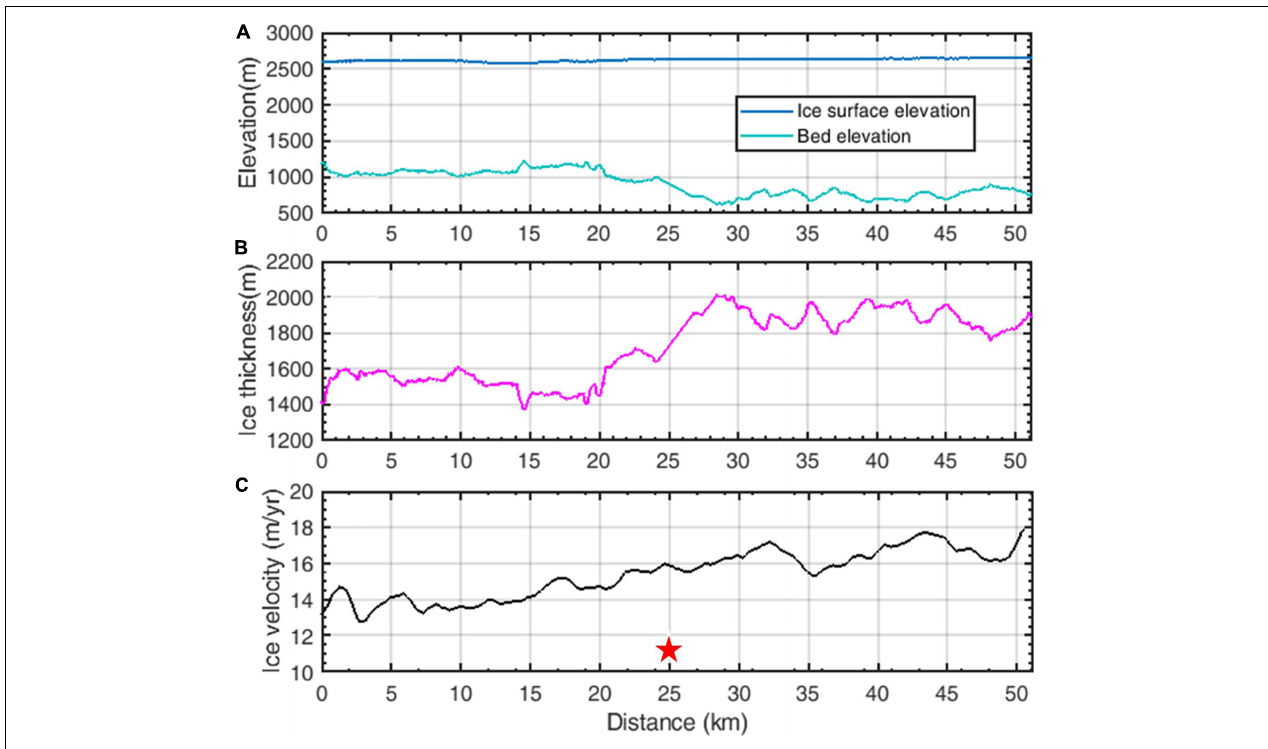
FIGURE 5 | (A) Surface and subglacial topography elevation, (B) ice thickness, and (C) ice velocity, from Rignot et al. (2011). The radar profile is shown in Figure 4A . The red star marks the position of Taishan Station.